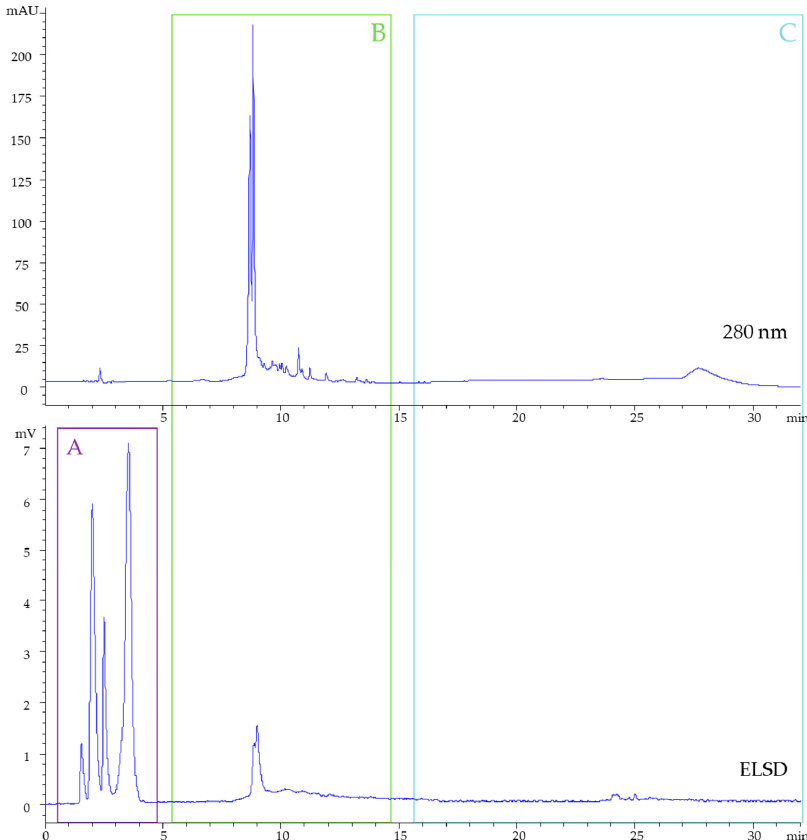
Figure 2. HPLC chromatograms obtained on a Luna ® C 18 column (150 × 4.6 mm; 5 µ m) at 280 nm and with ELSD, presenting the major families of compounds identified in R. nigrum pomace extract (group A : polar molecules, group B : polyphenols, group C : terpenes, terpenoids and fatty acids).